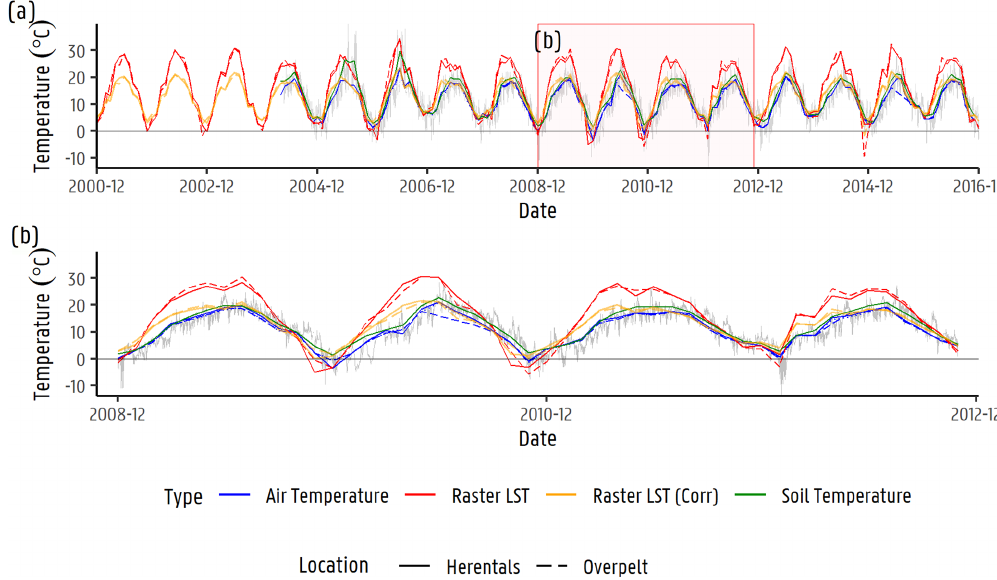
Figure A2. (a) Temperature–time series of air and soil measured in different stations within and nearby the Nete catchment. Corresponding raw and corrected average land surface temperature (LST) based on remote sensing data are presented as well. (b) Inset of panel (a) .